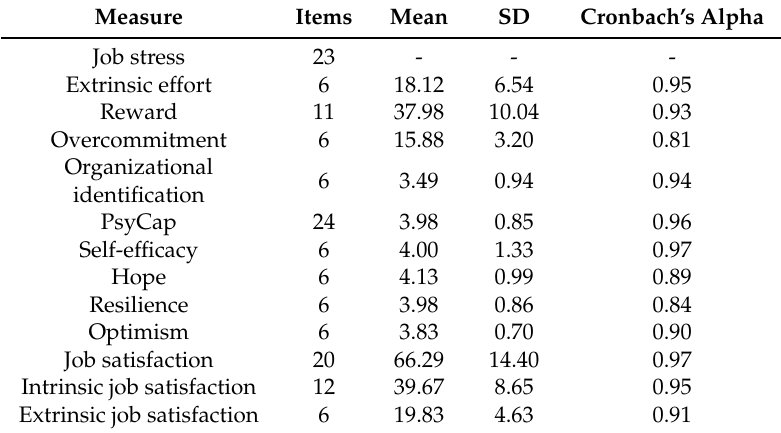
Table 2. Descriptions of job stress, organizational identification, PsyCap and job satisfaction.